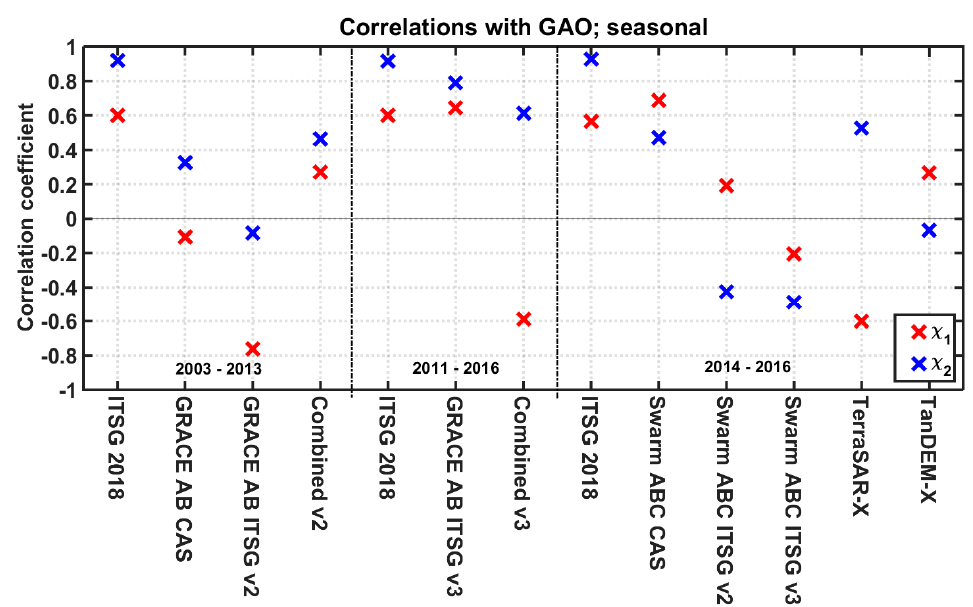
Figure 3. Correlation coefficients between seasonal changes of GAO and HAM obtained from ITSG 2018 GRACE solution (ll-SST) and solutions based on kinematic orbits of satellites (hl-SST). Because of the